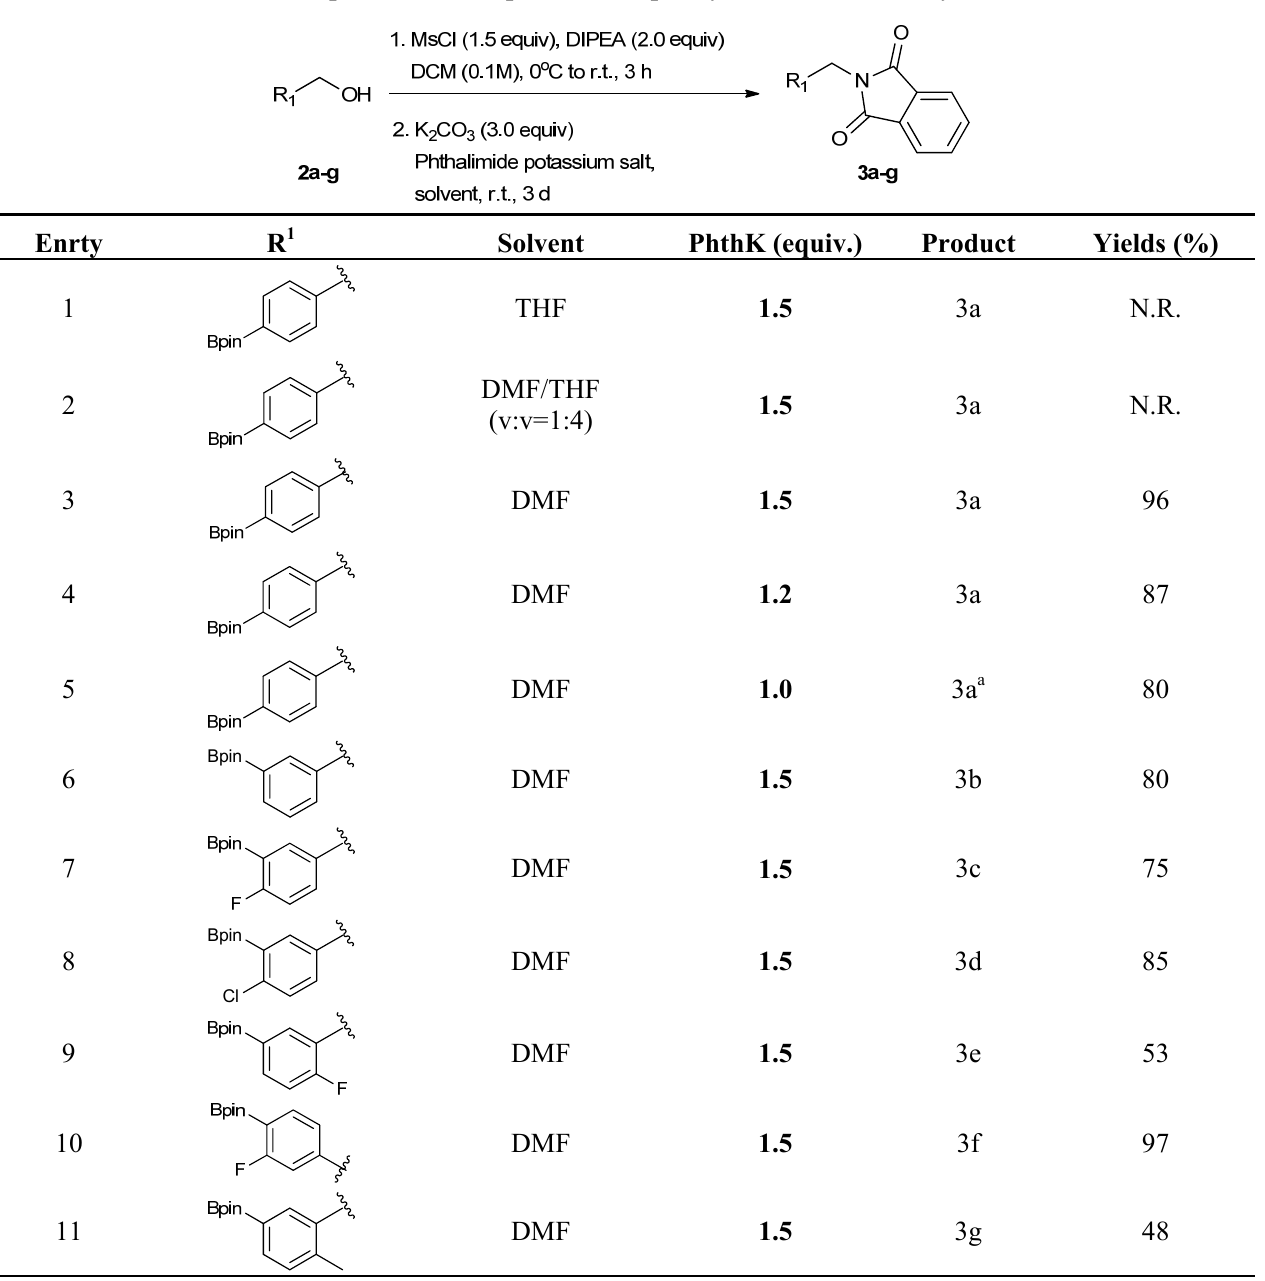
Table 2. Optimization of phthalimidophenyl boronate esters